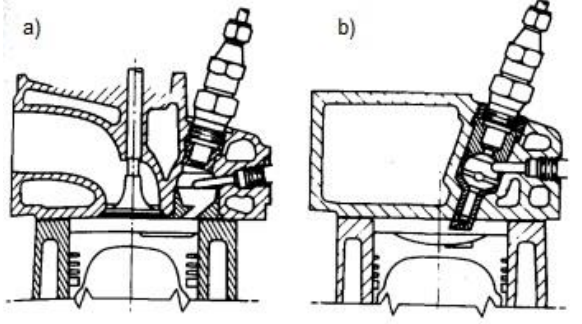
Fig. 5. Splitted chamber systems of CI engines: a) swirl chamber, b) prechamber [6]